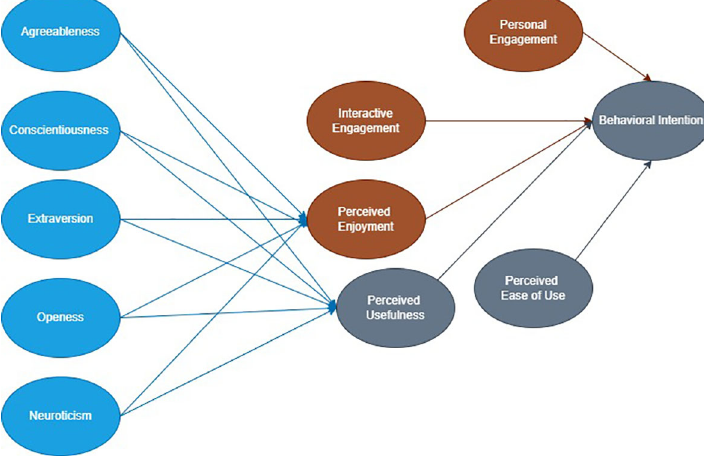
Figure 1. The conceptual framework of paid stickers in personal communication